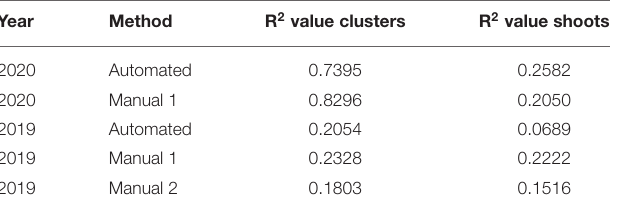
TABLE 2 | Performance of each method for cluster count estimation method.